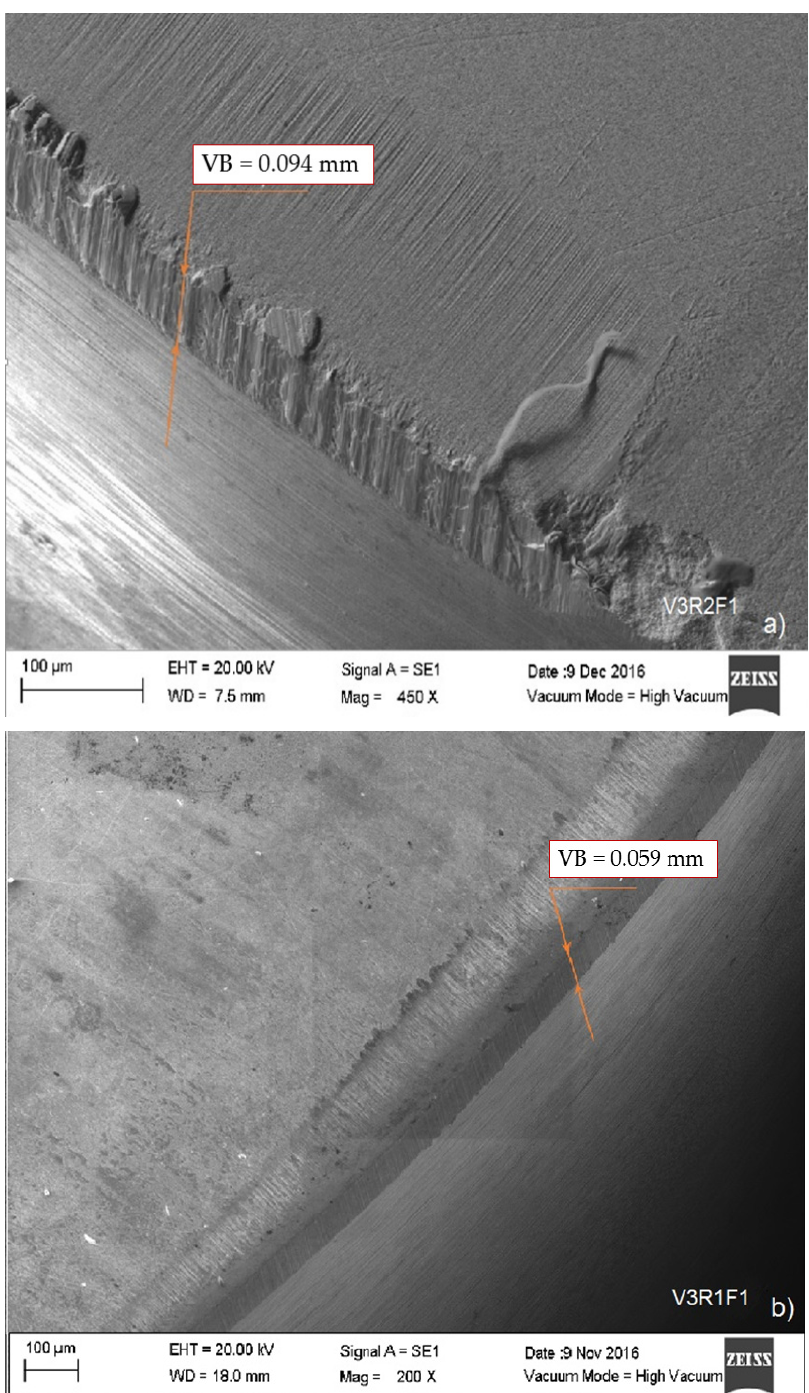
Figure 7. Wear on the incidence surface of the cutting tool for V = 400 m/min and f = 0.1 mm/rev: ( a ) dry and ( b ) with MQL.